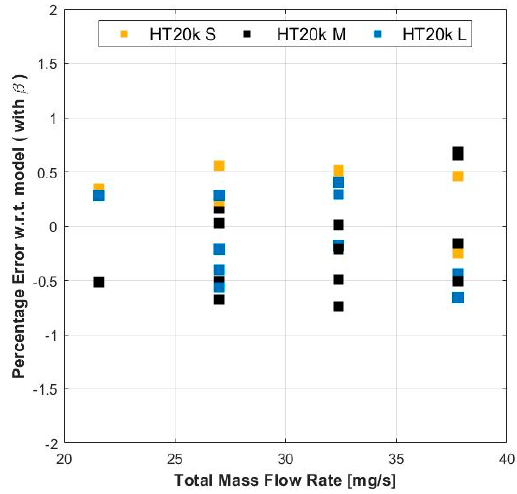
Figure 14. Percentage error regarding the model (with β = 49.6 ) for all 3 configurations; . ( app ) m the ∆ 7 − 5 was calculated from thrust